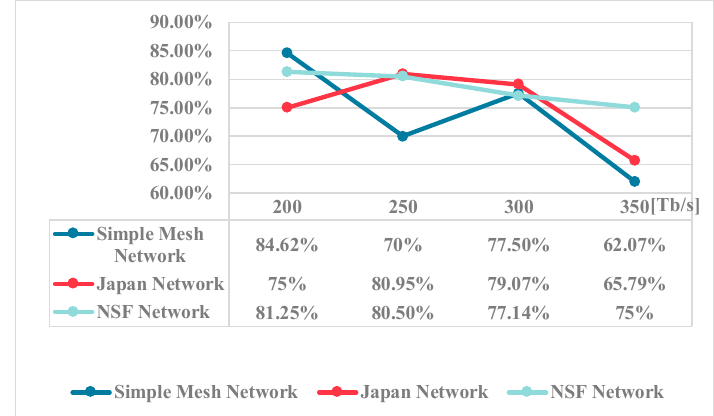
Figure 8. Percentage of traffic requests performing MFC.